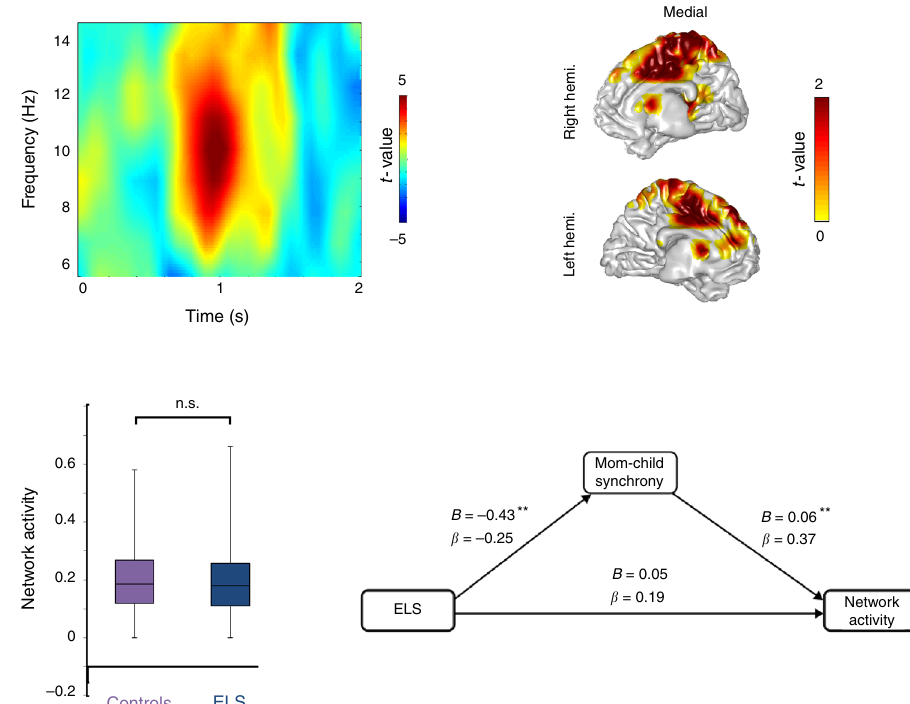
Fig. 2 Neural empathic response. Preadolescents activated the SMA/MCC (right upper panel) in response to vicarious distress ( masked for P cluster-cor < 0.05), and the color bar represents masked signi fi cant t values. This activation was expressed as late alpha-band enhancement (left upper panel). The red blob represents the signi fi cant time-frequency window ( P cluster-cor < 0.05), and the color bar conveys the t values. This neural effect of empathy was not signi fi cantly different between the two groups (left lower panel), yet mother – child synchrony in early and late childhood mediated (** P FDR-cor < 0.05) the effects of trauma exposure on this neural effect (right lower panel). In the chart bars, points are laid over a SEM (95% con fi dence